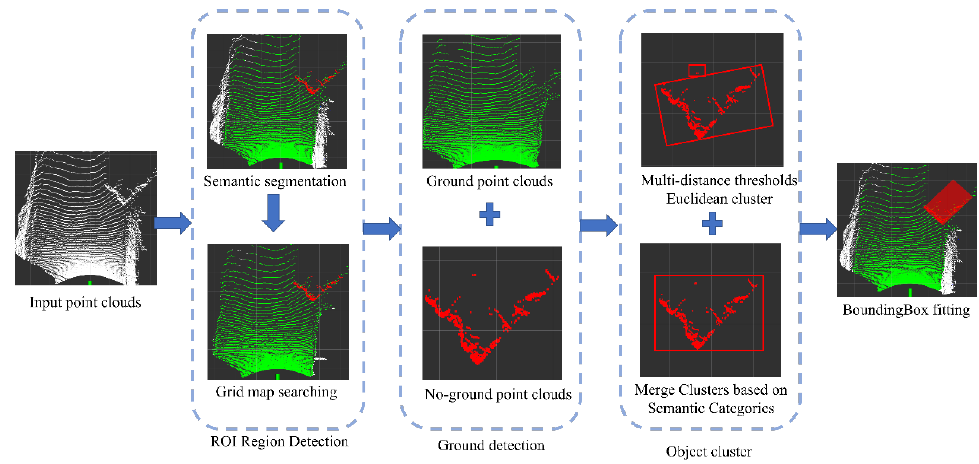
Figure 2. The pipeline of the proposed